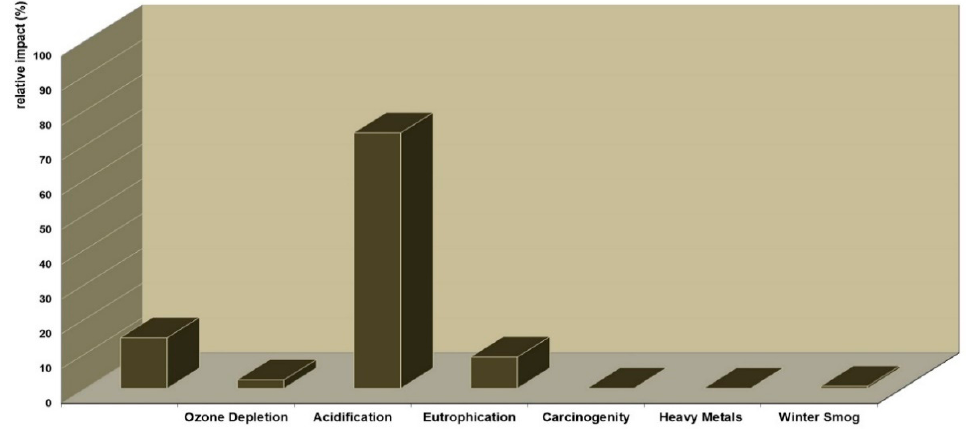
Figure 5. Environmental impact assessment of each category during GSHP ′ s system lifespan [17].